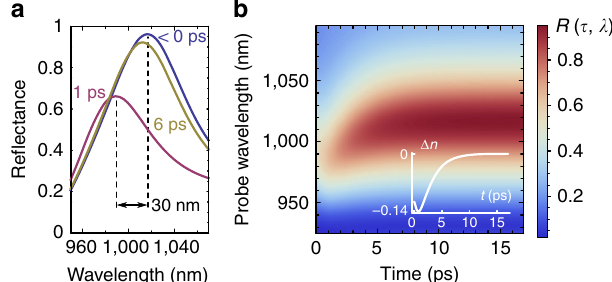
using COMSOL Multiphysics with Eqs. (2), (4), and (5) describing the refractive index dynamics. a Re fl ectance of the sample at τ < 0 ps (pre-pump, blue curve ), τ = 1 ps (carriers cooled, purple curve ) and τ = 6 ps (carriers recombined, yellow curve ). b Re fl ectance as a function of probe wavelength and time. The inset shows the time-dependent addition to the index of GaAs used in